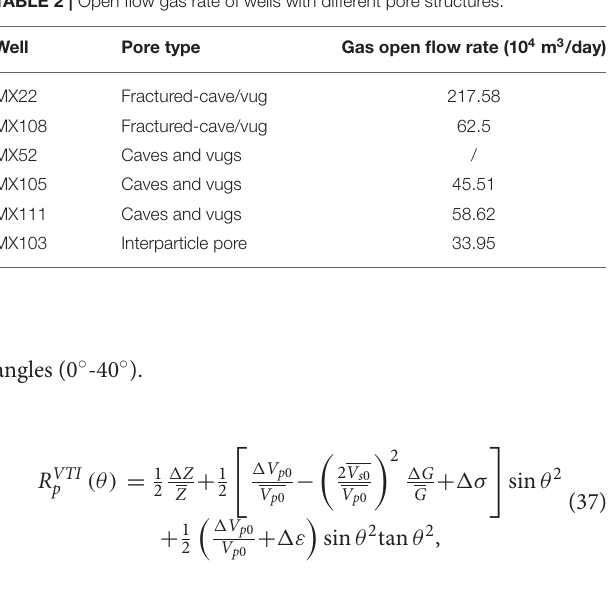
TABLE 2 | Open flow gas rate of wells with different pore